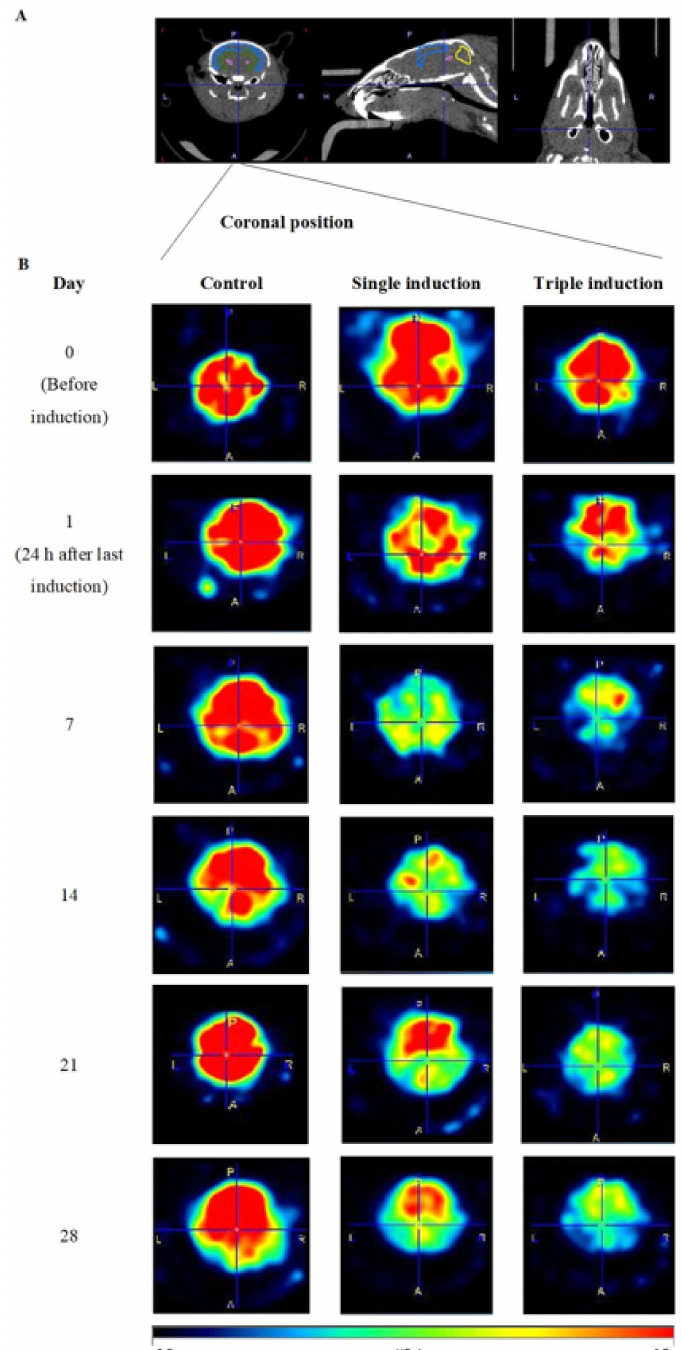
Figure 1. Representative micro PET images of 18 F FDG in control, single and repeated traumatic brain injury (TBI)-induced mice brains. ( A ) Representative CT images of a mouse at coronal, horizontal and sagittal position are shown above. ( B ) PET images of control, single and repeated/triple TBI mice brains at coronal position are represented below, at days 0 (before TBI induction), 1, 7, 14, 21 and 28, after last induction. Images in the first column represent control mice brains, in the second column are single TBI-induced mice brains and the third shows repeated TBI-induced mice brains at day 0 in the first row followed by days 1, 7, 14, 21 and 28 after last induction. The intensity of red color developed is proportional to the glucose ( 18 F FDG) uptake in mice brains and the scale bar is represented